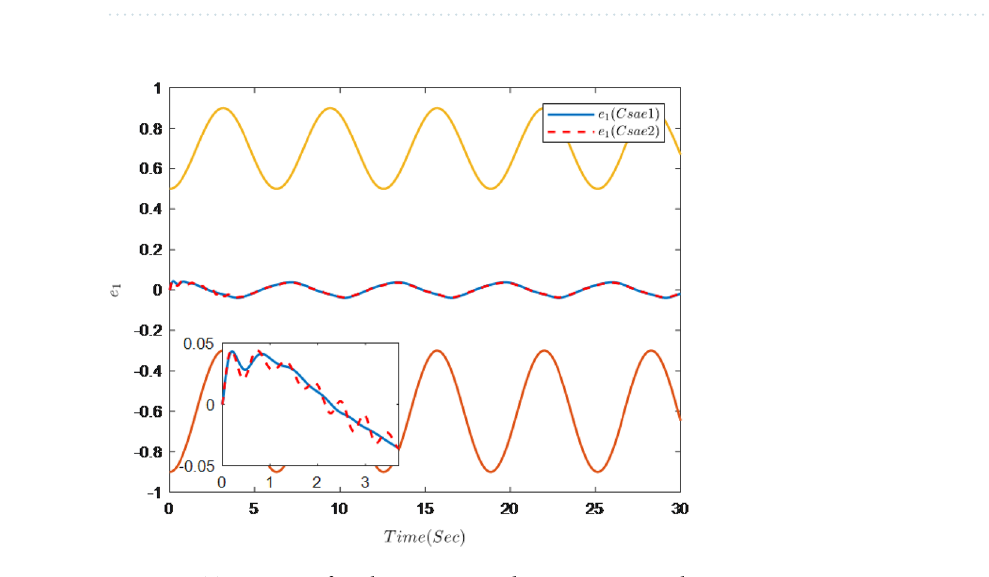
Figure 5. Trajectory of the system input u .